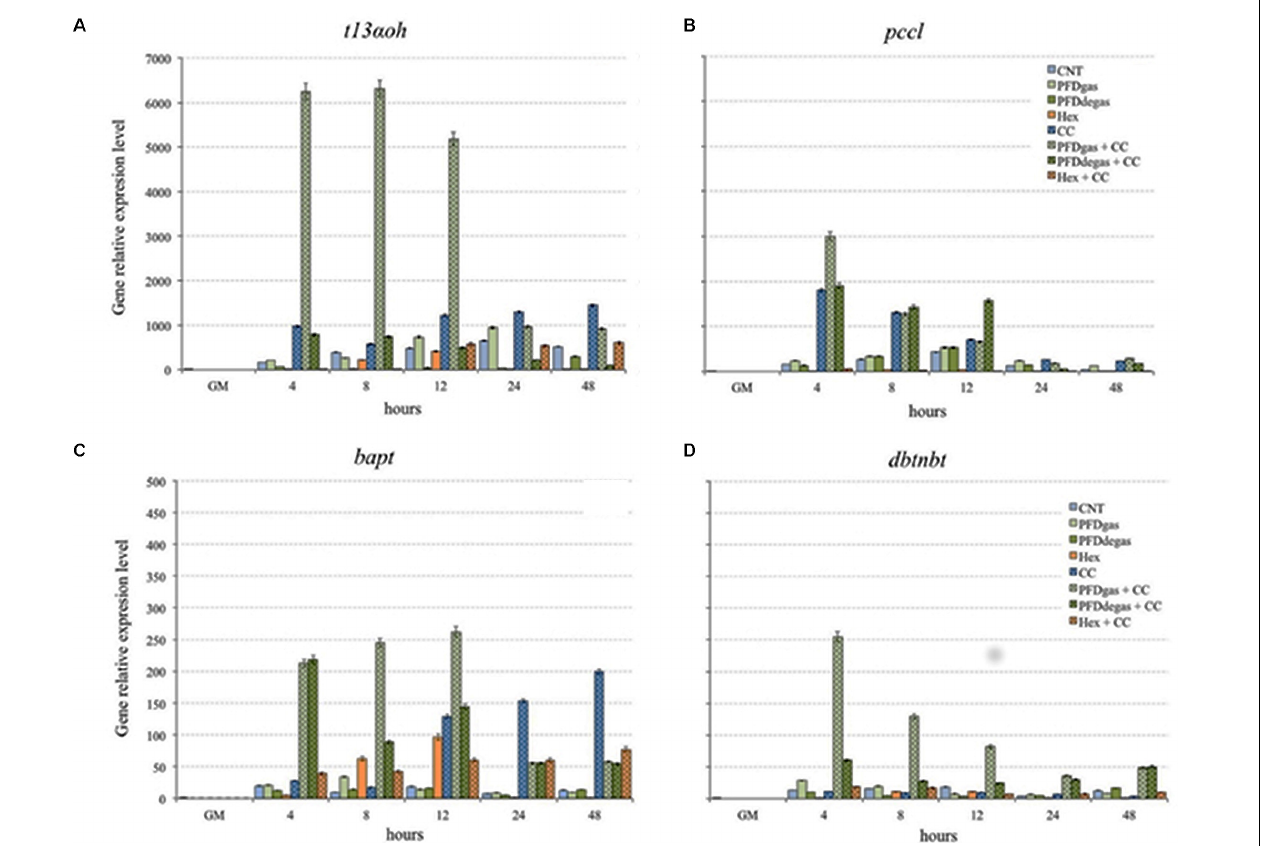
FIGURE 5 | Relative expression level of t13 α oh gene (A) , pccl gene (B) , bapt gene (C) , and dbtnbt gene (D) in T. media cell cultures elicited at 48 h of culture. GM, growth medium; CNT, control; PDFgas, gassed perfluorodecalins; PFDdegas, degassed perfluorodecalins; PDFgas + CC, gassed perfluorodecalins plus Coro and β -CDs; PDFdegas + CC, degassed perfluorodecalins and Coro + β -CDs; Hex, Hexenol; Hex + CC, Hexenol and Coro + β -CDs. Data are the mean of three independent replicates ±